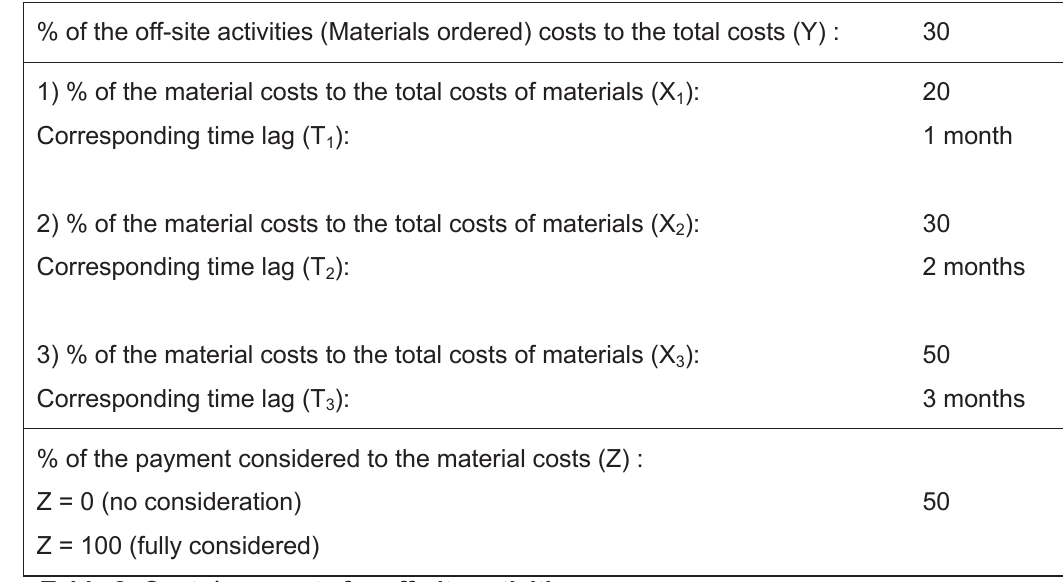
Table 2: Costs/payments for off-site activities